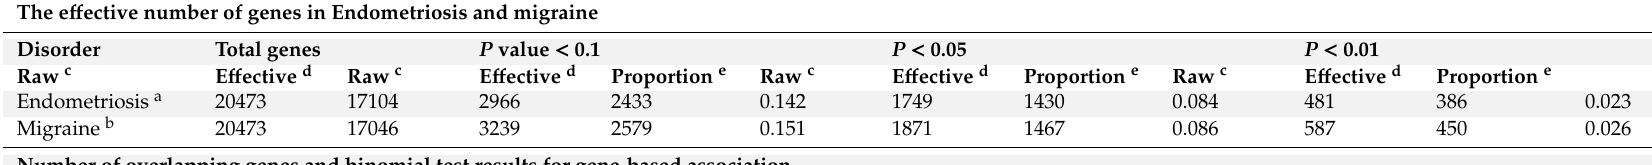
Table 5. Summary of gene-level association analyses for endometriosis and depression under three p -value